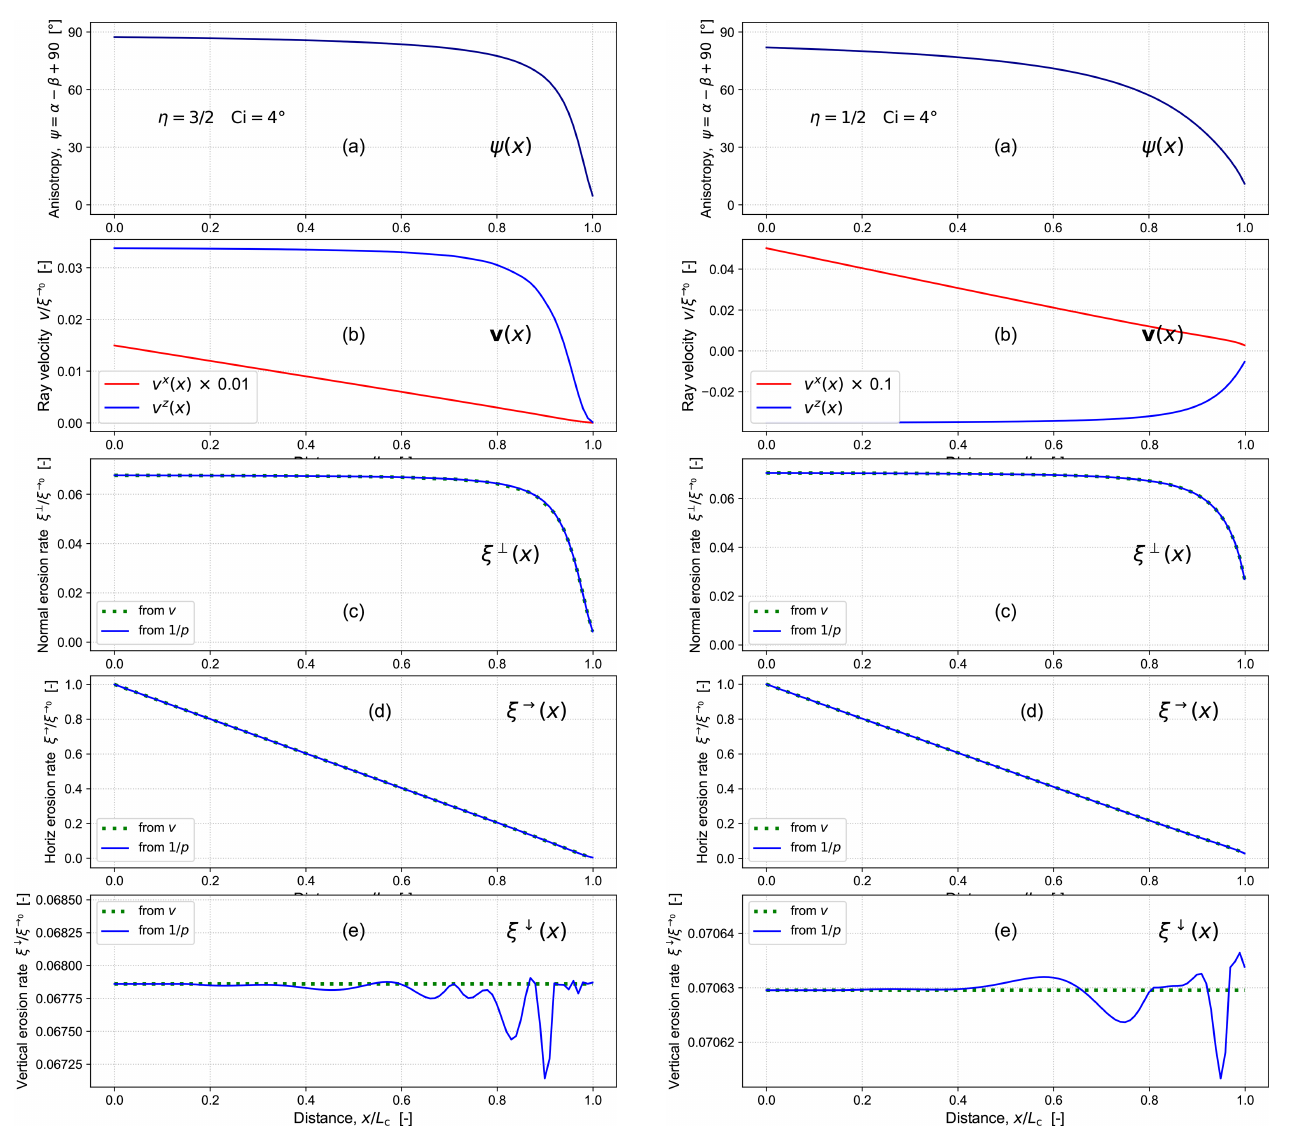
Figure 15. Ray and front behaviour along a time-invariant pro- and Ci = 4 ◦ : (a) anisotropy ψ , i.e. ray-front angular file for η = 3 2 disparity ( α − β + 90 ◦ ), (b) horizontal (red) and vertical (blue) ray speeds v x and v z , (c) surface-normal erosion rate ξ ⊥ , (d) horizontal erosion rate ξ → , and (e) vertical erosion rate ξ ↓ . All rates are nor- malized by the reference horizontal erosion rate ξ → 0 , i.e. the rate imposed at the boundary x = 0.